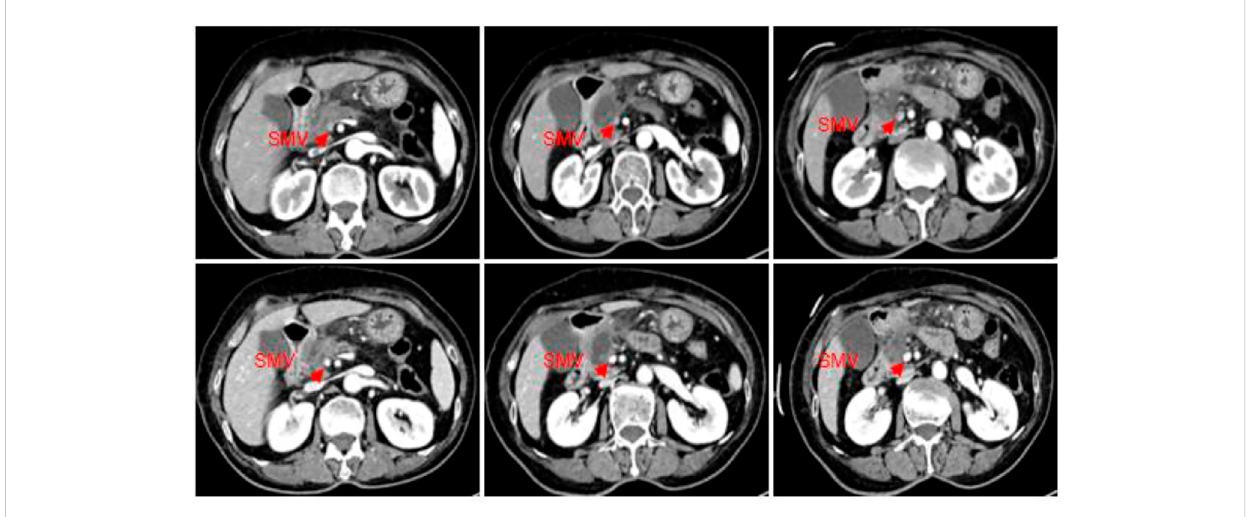
FIGURE 4 CT scan ofthe abdomen (2022.10.15): aslightly hypodense massof approximately 35*28 mm with mild edge enhancementwas seen in theneck of the pancreatic head, with a slightly reduced lesion compared to the last imaging (2022.09.26), and with a relief of the proximal stenosis in the adjacent SMV. Itshowed better improvement than before for thevagueedemaand thickeningof thelateral wall ofthegreatercurvatureof thegastric antrum and the colorectal wall, and the vague in fl ammatory exudation of the gastrocolic ligament. The tumor was 20% smaller than in the last review.